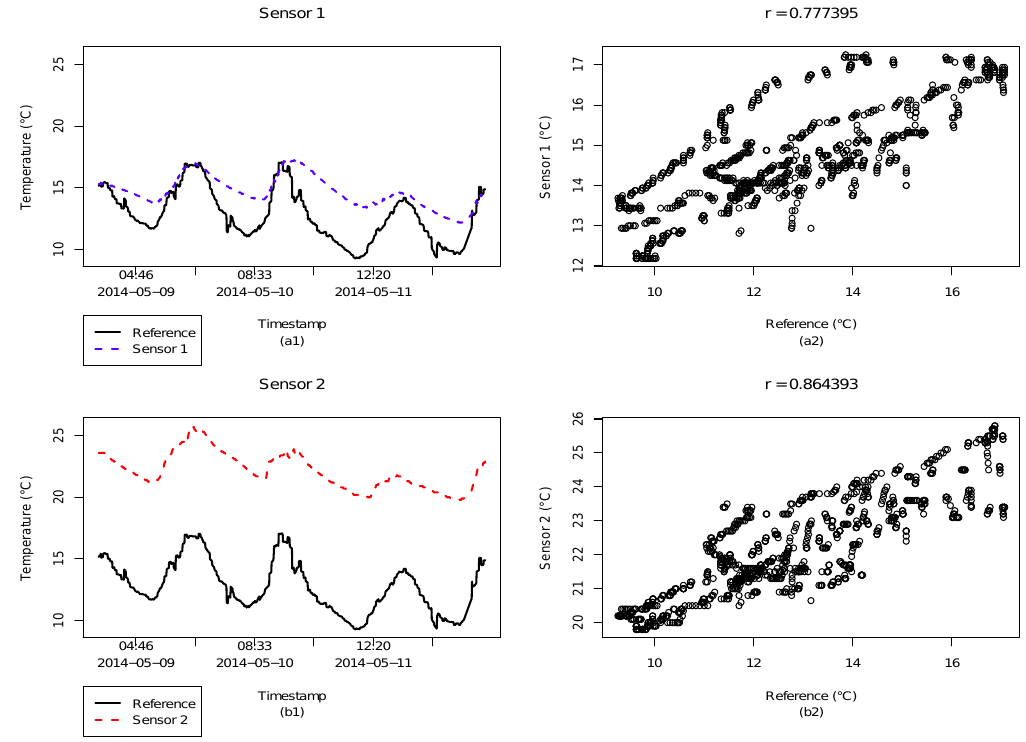
Figure 6. Time series ( a1 ) and scatter plot ( a2 ) analysis for a r = 0 . 777395 related sensor, and time series ( b1 ) and scatter plot ( b2 ) analysis for a r = 0 . 864393 sensor (Dataset